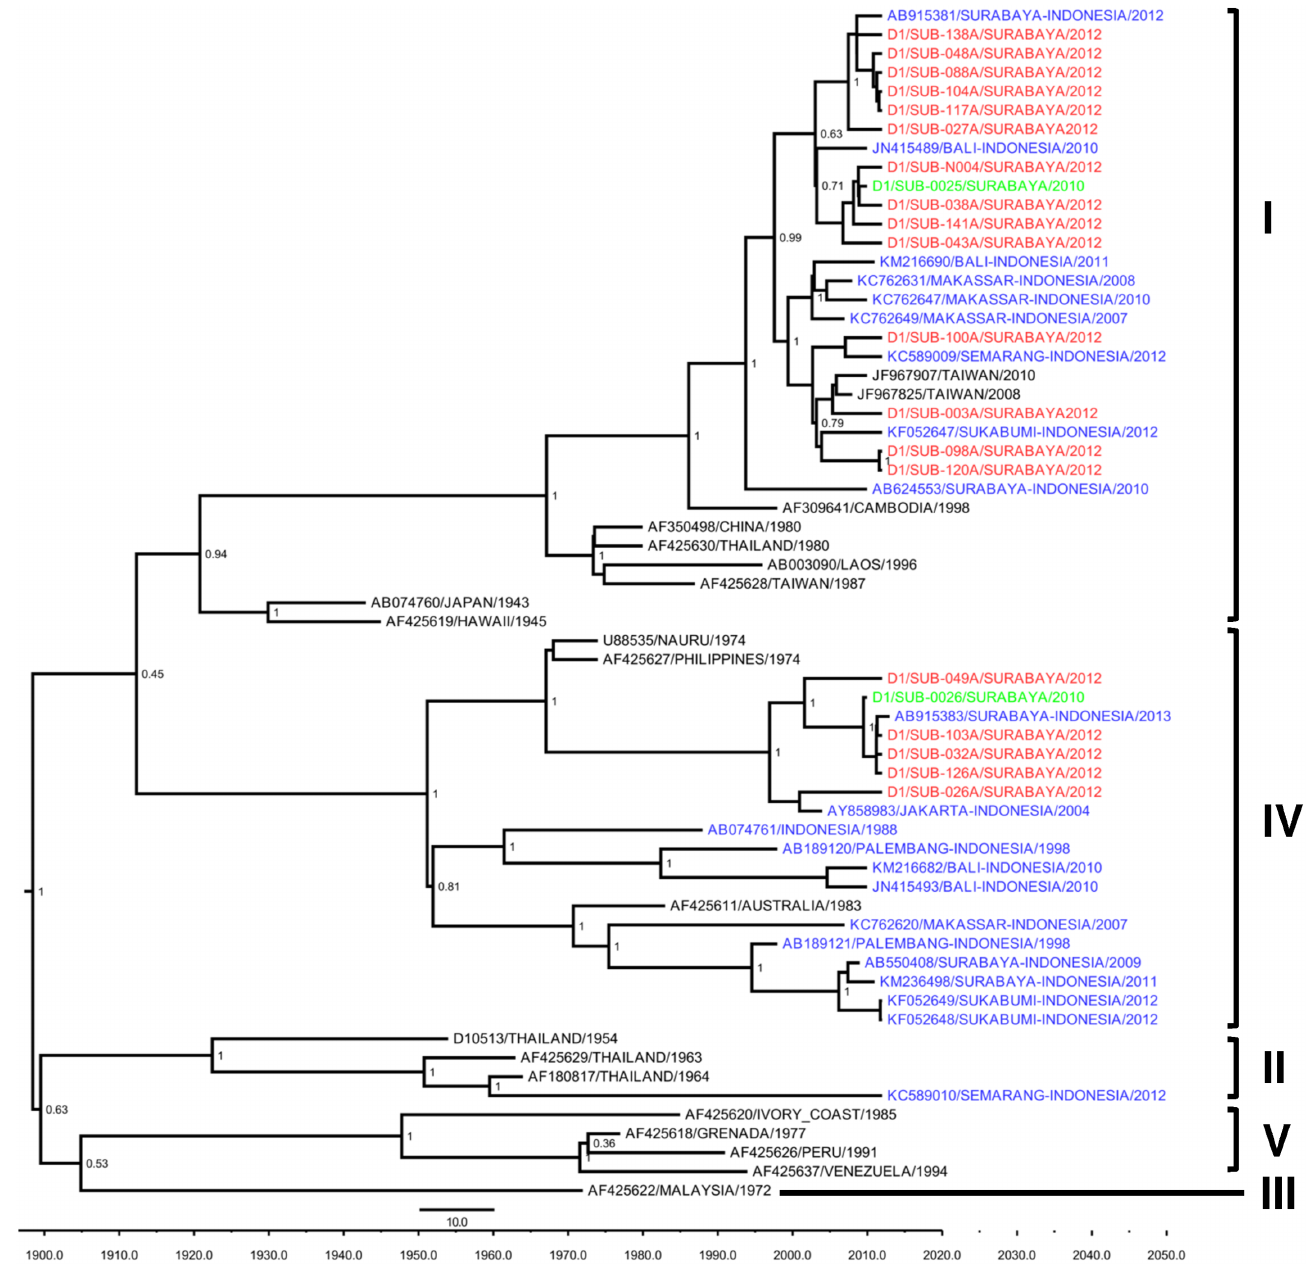
Fig 2. Maximum clade credibility (MCC) tree of DENV-1 genotype groupings generated by Bayesianinference method as implemented in BEAST using the GTR evolution model and gamma parameter rates from the E gene sequences. The Surabaya2012isolates (red font) were groupedinto Genotype I and Genotype IV basedon classificationby Goncalvezet al [27], togetherwith isolates from Surabaya2010 (green font) and other cities in Indonesia(blue font). The posterior probabilities of the clades are indicatedas numbers in the node